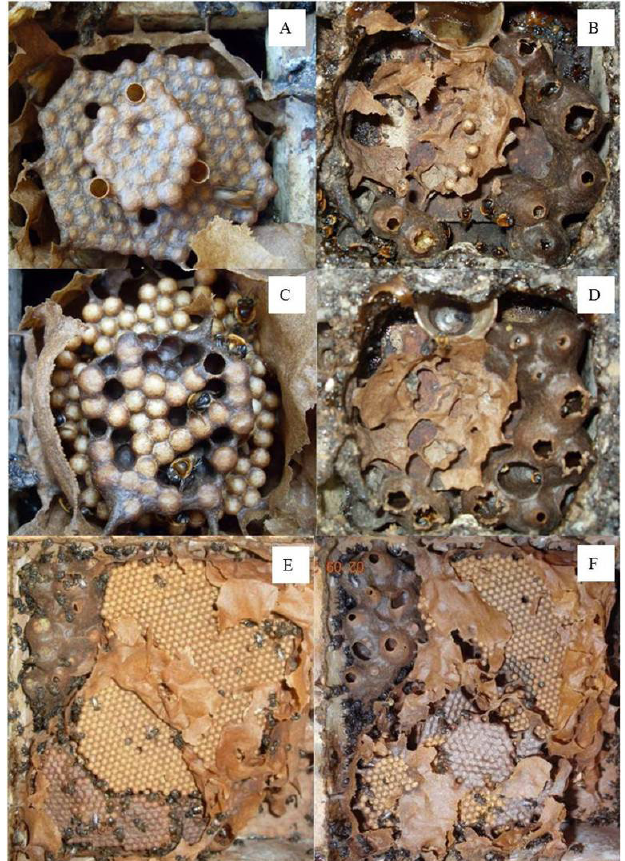
Fig 2 . Development stages of stingless bees colonies used for pollina- tion of mini watermelon ( Citrullus lanatus ) under a greenhouse. A - Brood combs in a Melipona subnitida colony at the beginning of the pollination services. B - Food stores in a Melipona subnitida colony at the beginning of the pollination services. C - Brood combs in a Melipona subnitida colony at the end of the pollination services. D - Food stores in a Melipona subnitida colony at the end of the pollination services. E - Brood combs and food stores in a Scaptotrigona sp. nov. colony at the beginning of the pollination services. F - Brood combs and food stores in a Scaptotrigona sp. nov. colony at the end of the pollination